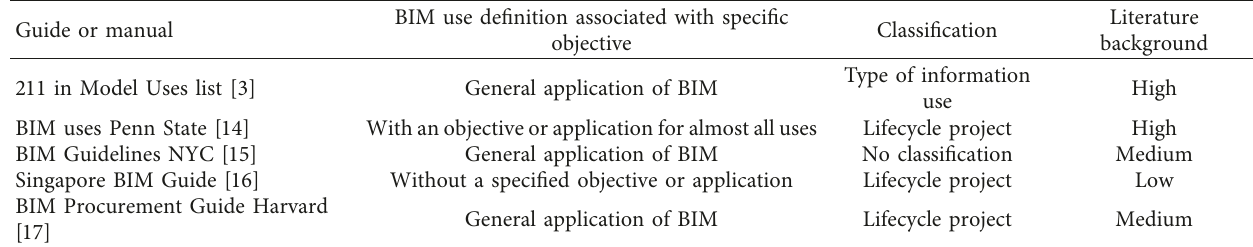
Table 3: Characteristics of BIM use guides and manuals.